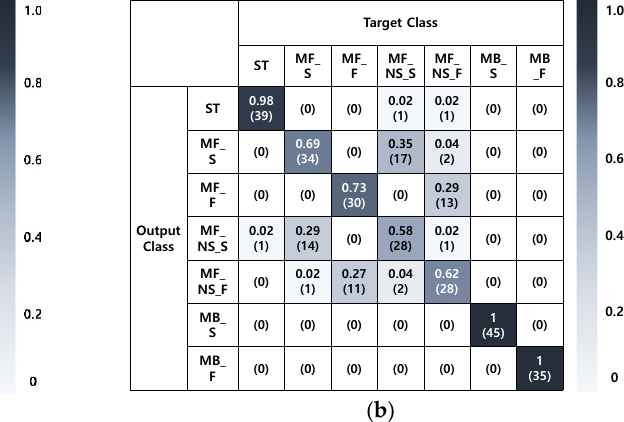
Figure 8. Confusion Matrix from the Outdoor Experiment: ( a ) 5 classes, ( b ) 7 classes. Table 5. Performance of the Proposed Model in the Outdoor Environment.